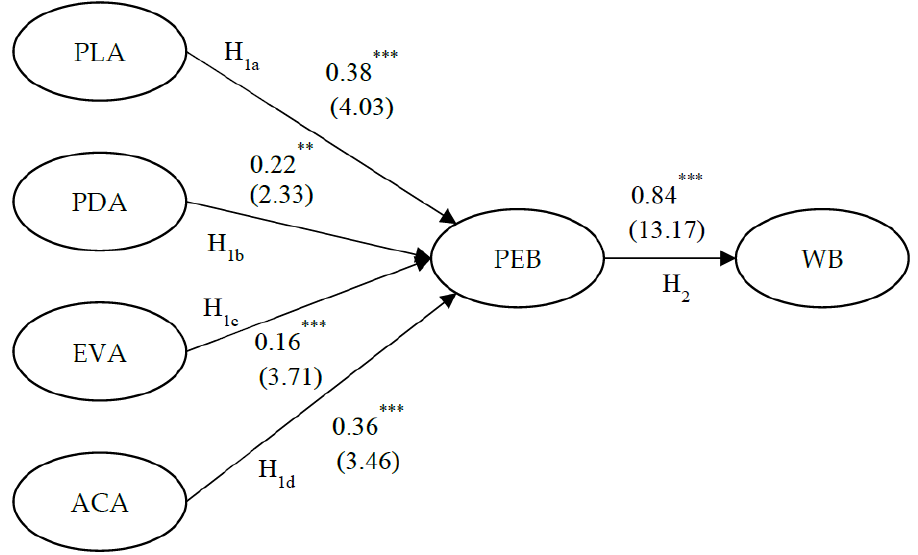
Figure 1. Path coefficients of the structural model. Note: *** p < 0.001, ** p < 0.010. The error variation was positive for the primary goodness-of-fit index of this research model. The coefficient ranged from 0.71 to 0.98, and Cronbach’s α ranged from 0.910 to 0.948. The composite reliability (CR) ranged from 0.890 to 0.959, which surpasses the recommended 0.7 [89]. Meanwhile, the average variance extracted (AVE) ranged